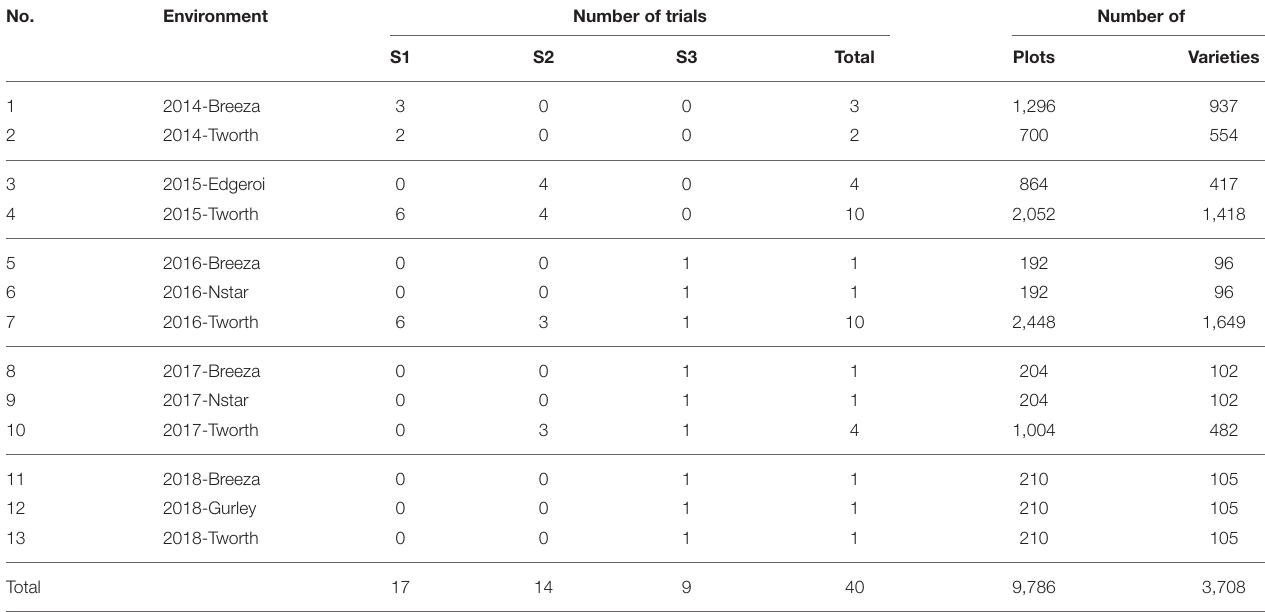
TABLE 1 | Durum example: Summary of environments in the durum MET dataset.